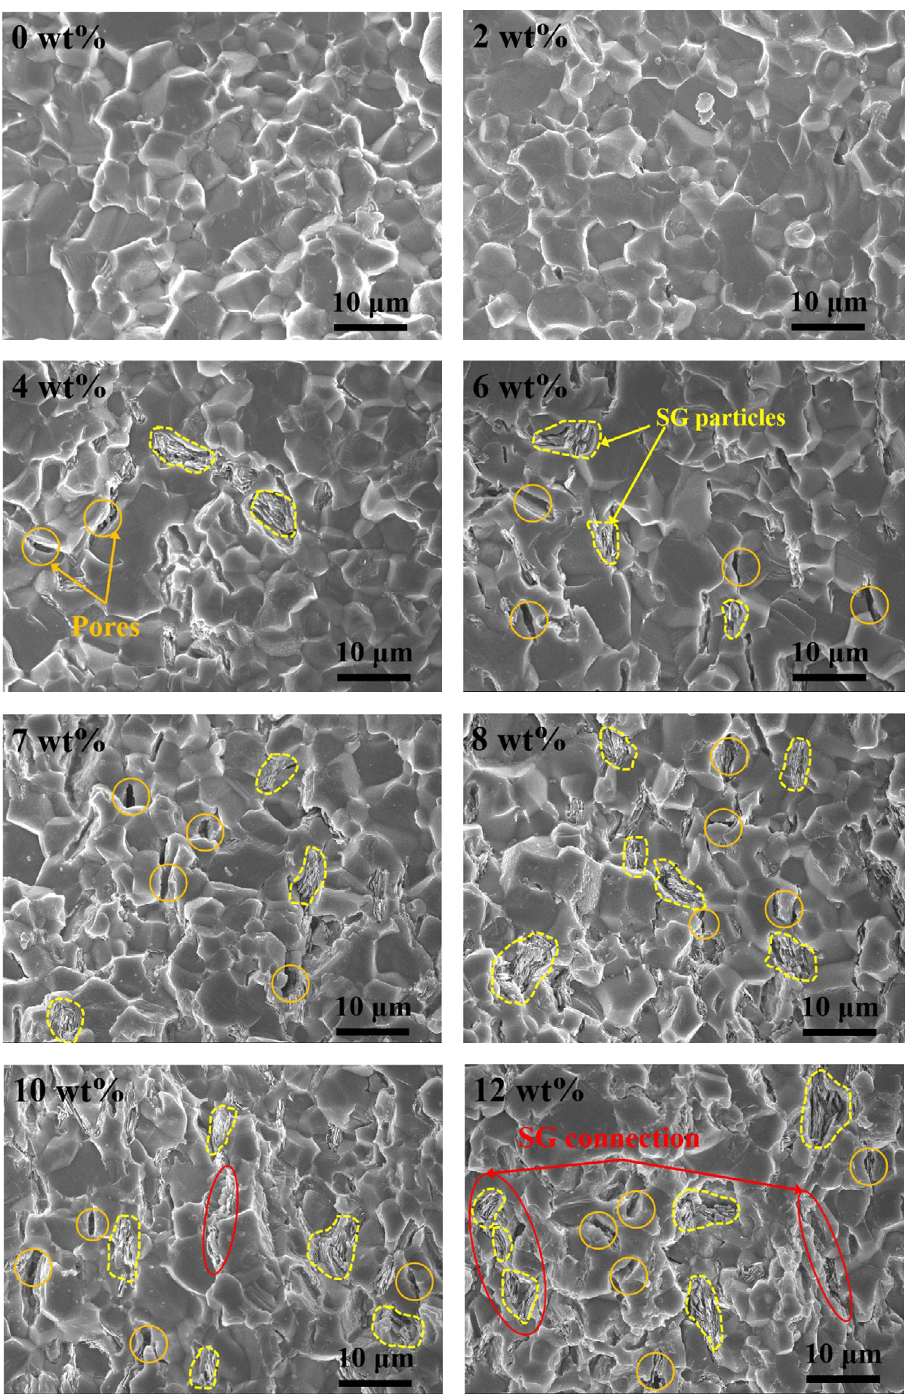
Fig. 8 Fracture morphologies of SG/AlN composites with different SG